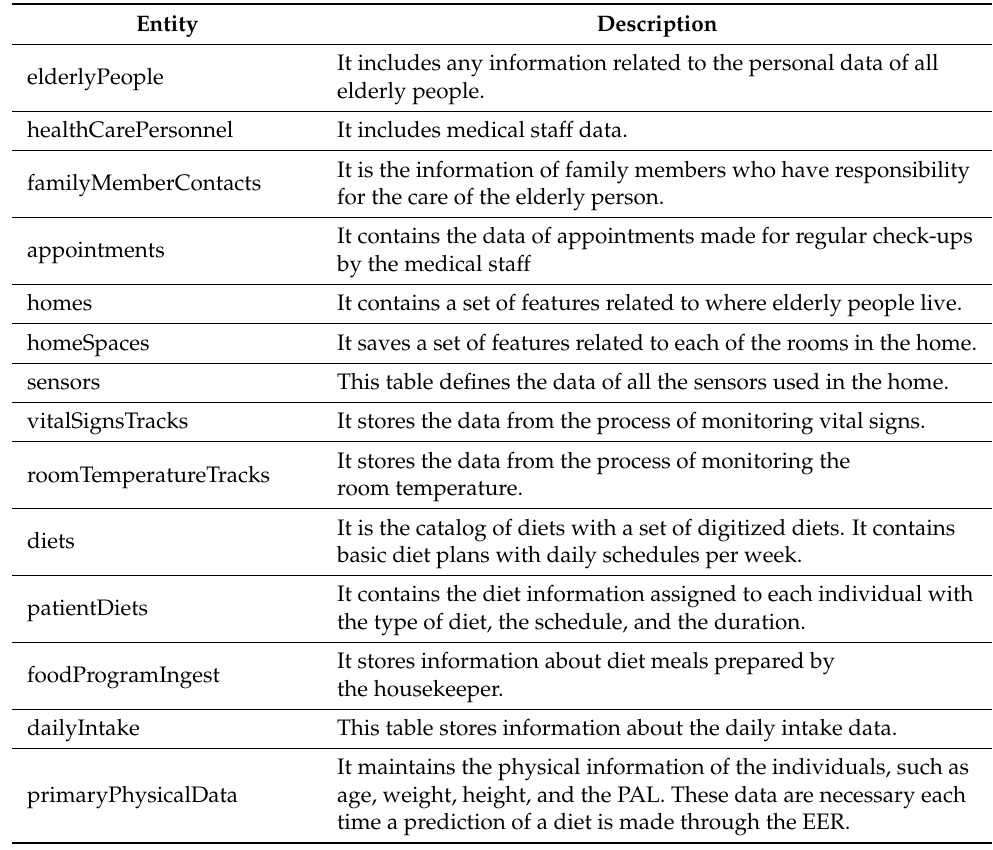
Table A1. Description of the data model